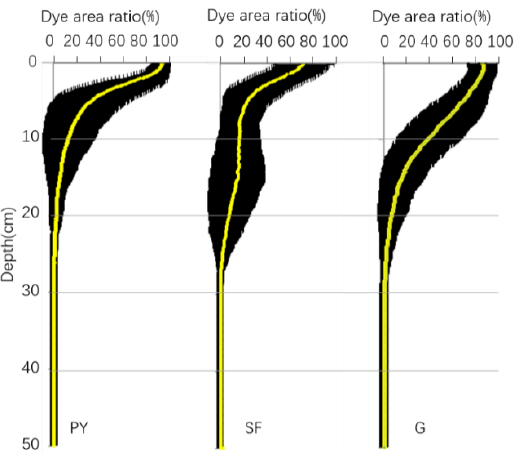
Figure 3. Average dye coverage ( DC ) (yellow curve) and standard deviation (black part) of three site types. PY corresponds to Pinus Yunnanensis , SF corresponds to secondary forestland, and G corresponds to natural grassland.